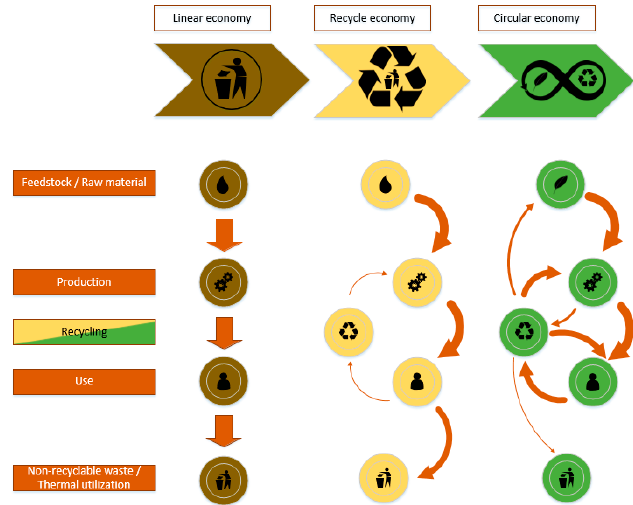
Figure 1. Linear, recycle and circular economy concept.